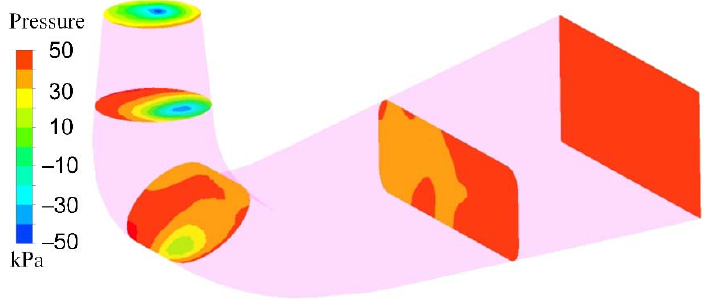
Figure 7. Instantaneous static pressure field in five sections of the draft tube (16 deg GVO).